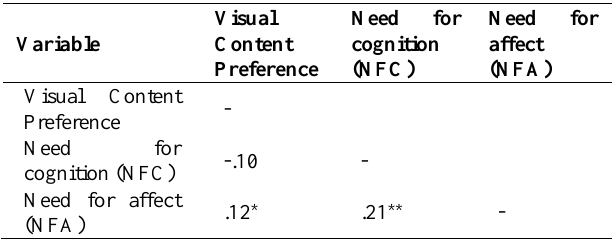
Table 1: Pearson correlation matrix among personality traits and visual content